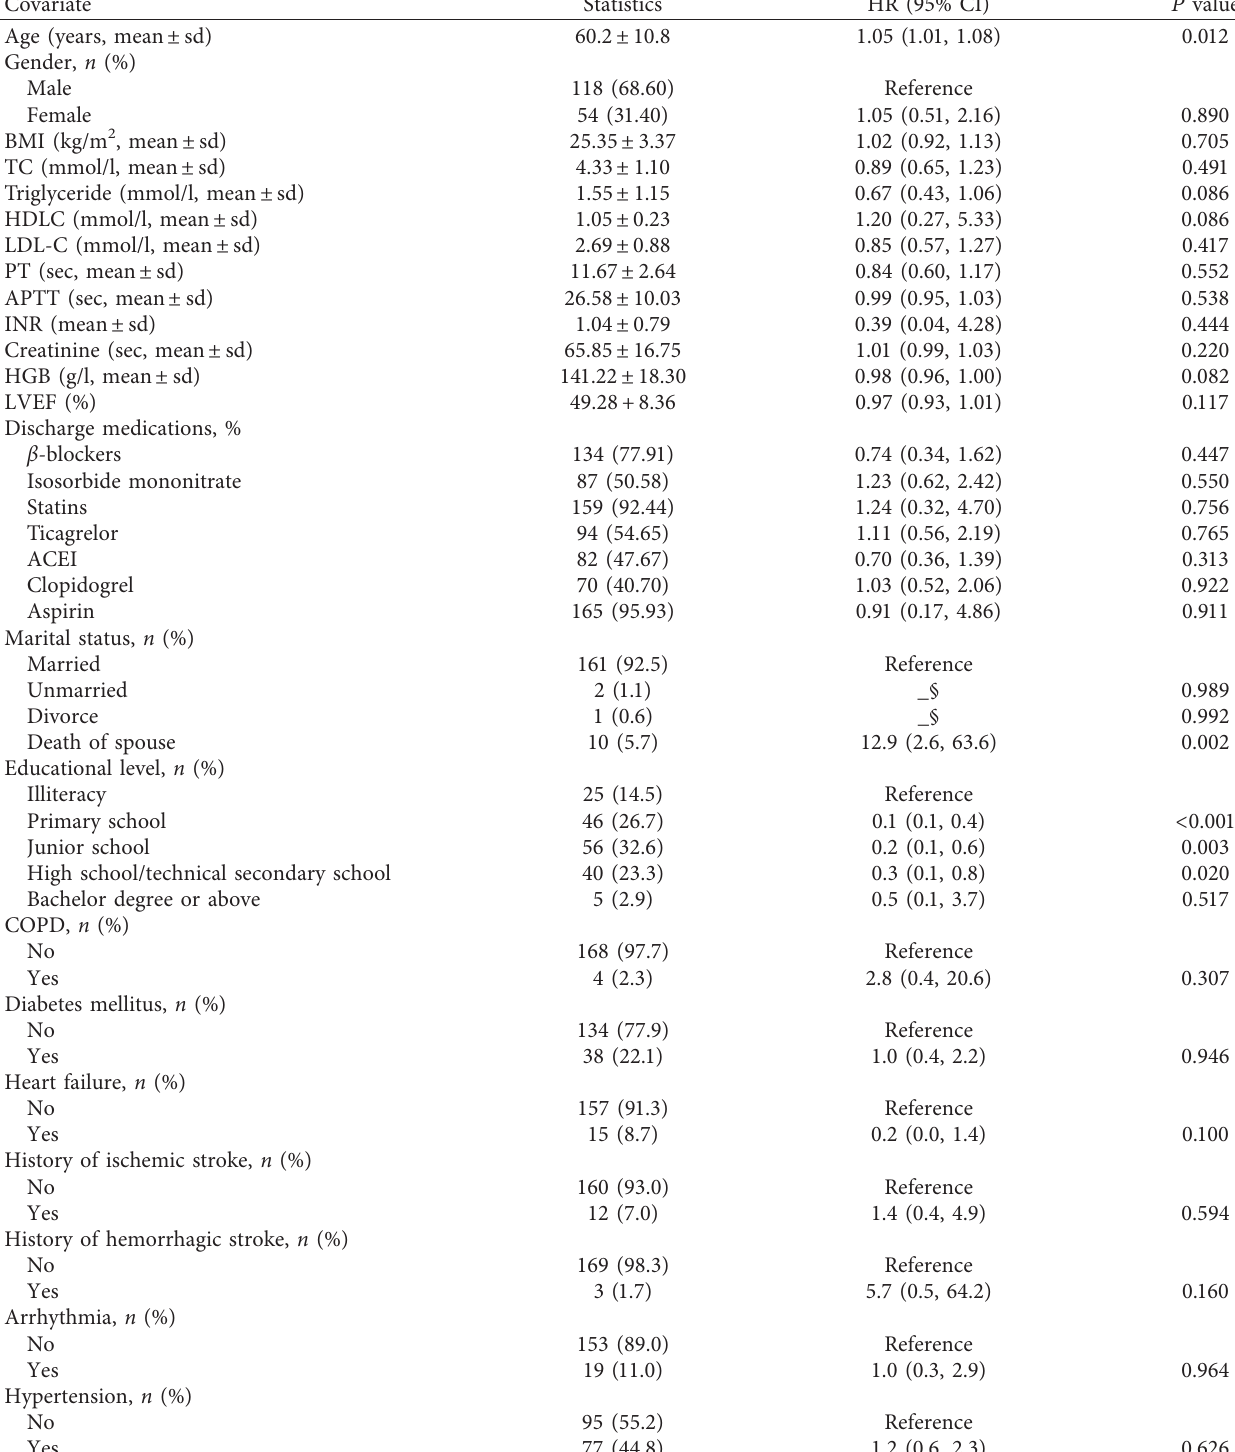
Table 2: Univariate analysis for readmission of